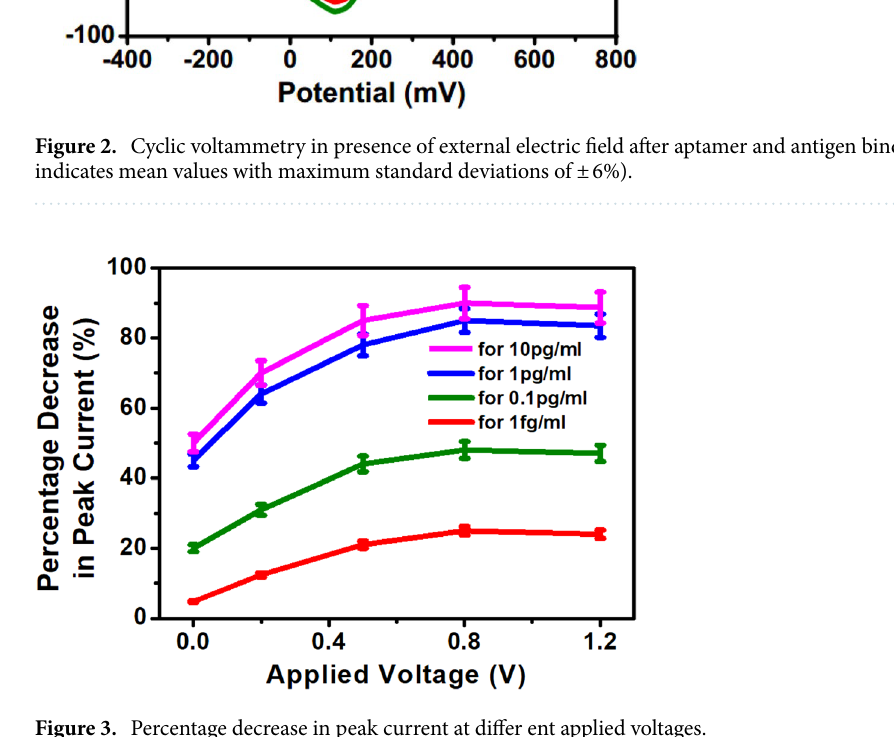
Figure 3. Percentage decrease in peak current at differ ent applied voltages.